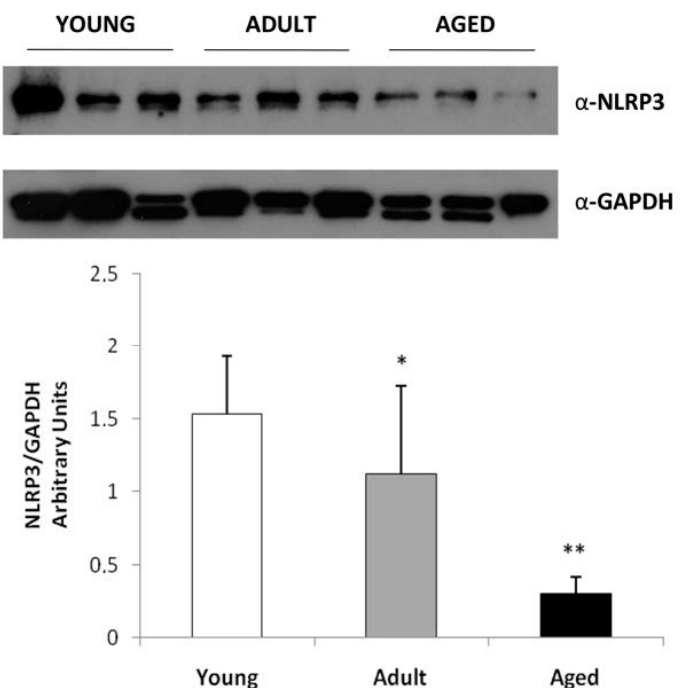
Figure 5. Western blot analysis for NLRP3 inflammasome expression in bovine muscle during aging. Skeletal muscle tissue from young, adult and aged bovine was homogenized and the protein lysates were analyzed by Western blot using antibodies for NLPR3 and for GAPDH as control. The blots were detected by ECL and autoradiography. In skeletal muscle of young bovine there is an increase of immunoreactivity for NLPR3 inflammasome compared to adult and aged animals. Data are shown as mean ± SD and asterisks denote statistically differences (* p < 0.05; ** p < 0.01).